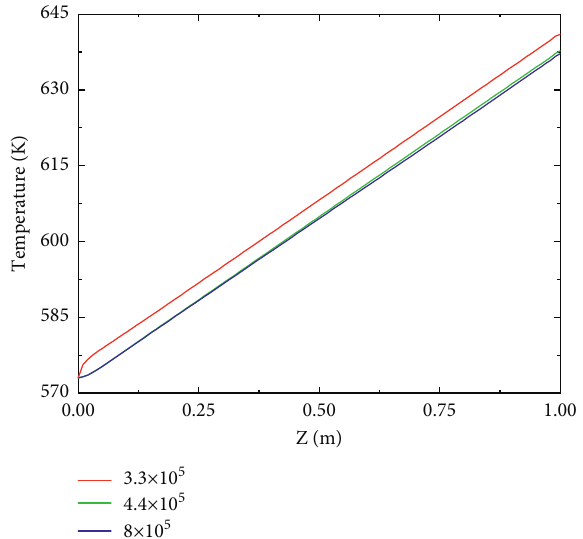
Figure 4: Temperature variation along the axial direction in mesh cases.